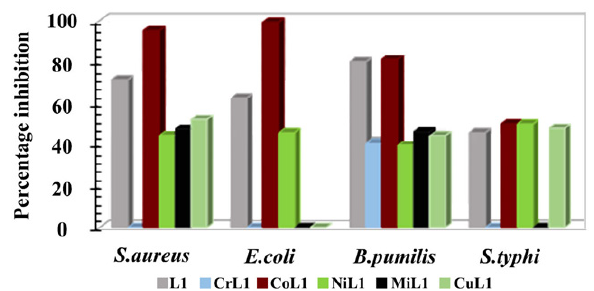
Fig. 7 . A comparative histograms inhibition zone Antibacterial As- say of MBHA and compound 4-8 , S.typhi, E.coli are two Gram-neg- ative bacteria and B.subtilis, S.aureus are two Gram- positive bacte-